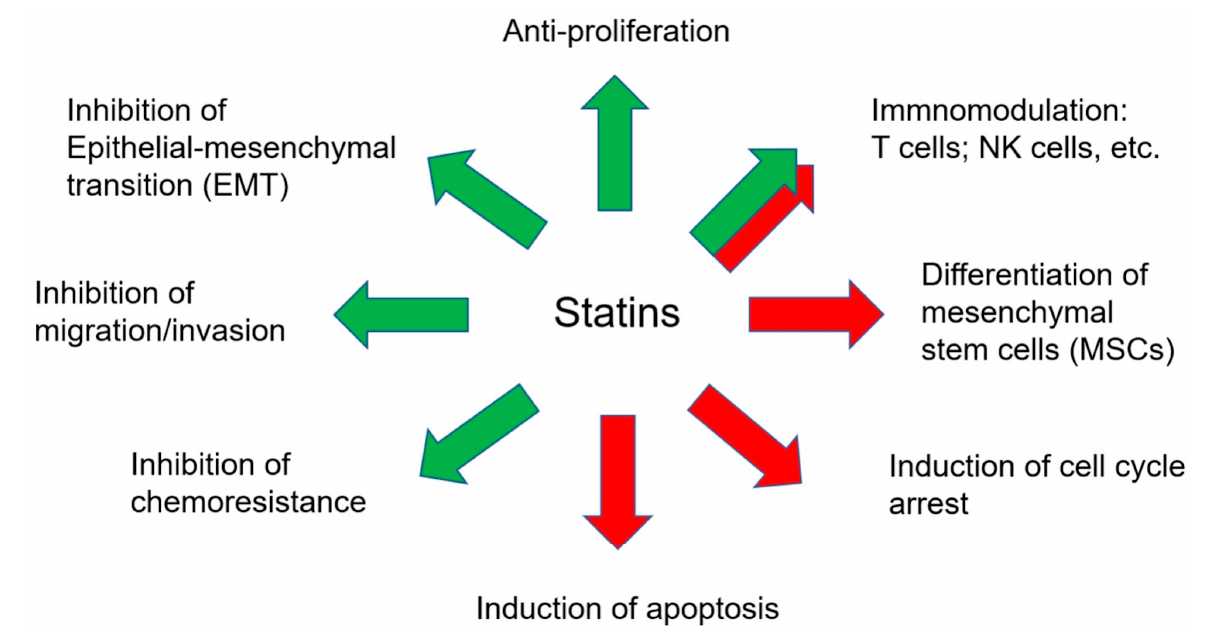
Figure 1. The mevalonate pathway and the role of statin in regulating tumor progression and bio- synthesis of cholesterol.